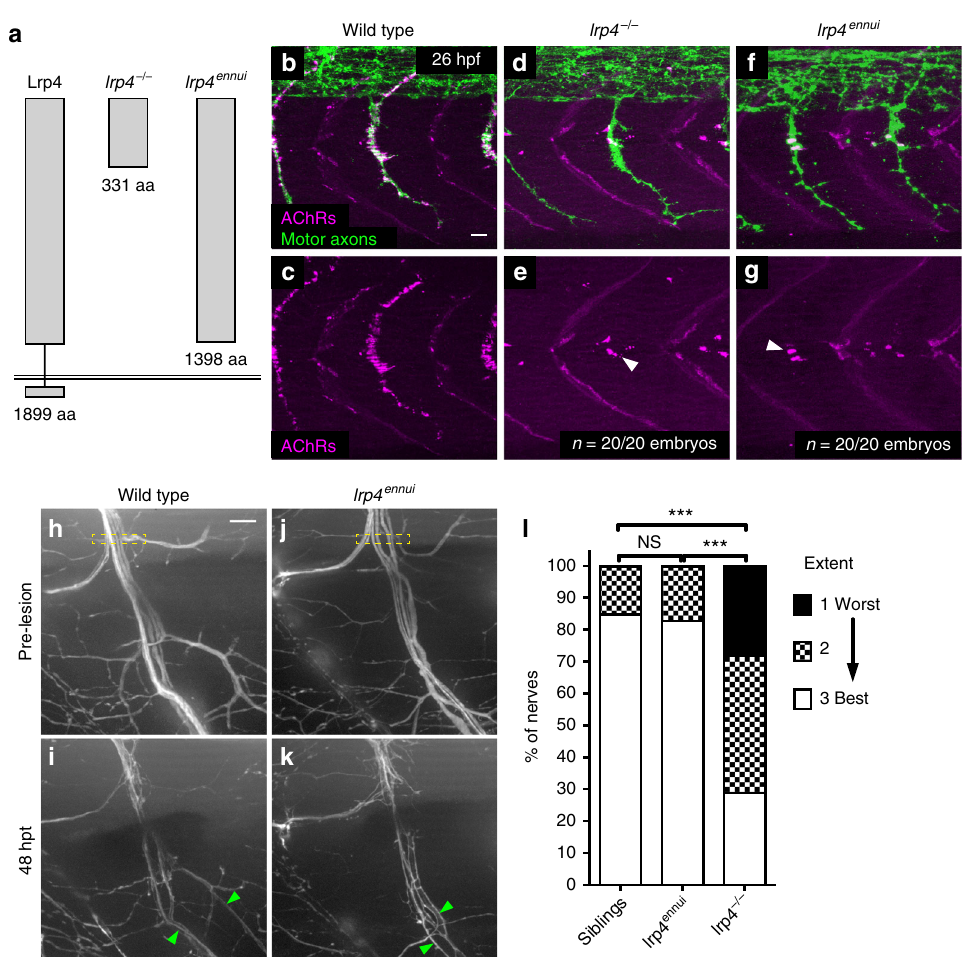
Fig. 5 A truncated version of Lrp4 promotes nerve regeneration. a Schematic of lrp4 alleles and their protein structures: wild-type full-length Lrp4 is shown at far left (1899 amino acids). lrp4 − / − allele encodes a protein of 331 amino acids. lrp4 ennui encodes a protein of 1398 amino acids that is predicted to contain almost the entire ectodomain but lack the transmembrane and intracellular domains. b – g Lateral views of wild type, lrp4 − / − , and lrp4 ennui embryos at the stage when en passant neuromuscular synapses form (26 hpf) stained for acetylcholine receptors (AChRs; magenta) and motor axons (green). Scale bar is 10 µ m. b – c In wild-type embryos, AChR clusters assemble beneath the entire motor axon. d – g In lrp4 mutant and lrp4 ennui embryos there is a strong reduction in AChR clustering beneath the motor axon, with only a few AChR clusters observed (white arrowheads); n = 20 out of 20 embryos examined for each genotype. h Lateral view of pre-transection wild-type motor nerve labeled with GFP at 5 dpf. Transection site is marked by yellow box. Scale bar is 10 µ m. i Forty-eight hours post transection in wild-type larvae, multiple fascicles have regenerated ventrally (marked by green arrowheads). j Lateral view of pre-transection motor nerve in lrp4 ennui labeled with GFP at 5 dpf. Transection site marked by yellow box. k Forty-eight hours post transection in lrp4 ennui , multiple fascicles have regenerated ventrally (green arrowheads). l Quanti fi cation of nerve regeneration in wild-type larvae ( n = 26 nerves from 13 larvae), lrp4 mutants ( n = 28 nerves from 13 larvae) and lrp4 ennui ( n = 24 nerves from 9 larvae) at 48 h post transection. lrp4 ennui nerves regenerate to the same extent as wild-type sibling nerves (wild-type siblings “ best ” regeneration = 85% of nerves; lrp4 ennui “ best ” regeneration = 83% of nerves; χ 2 -test p = 0.1672, χ 2 = 3.577, df =